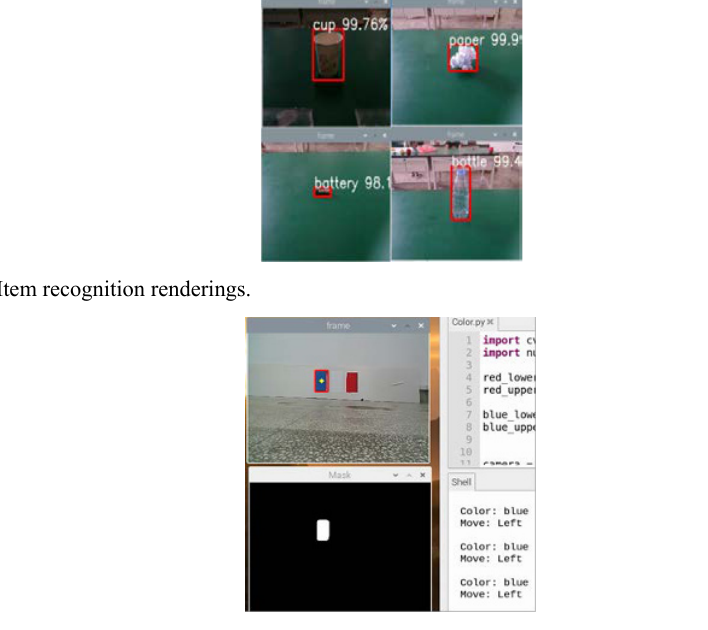
Fig.10. Color navigation interface. Table 2. Item recognition average accuracy and sorting